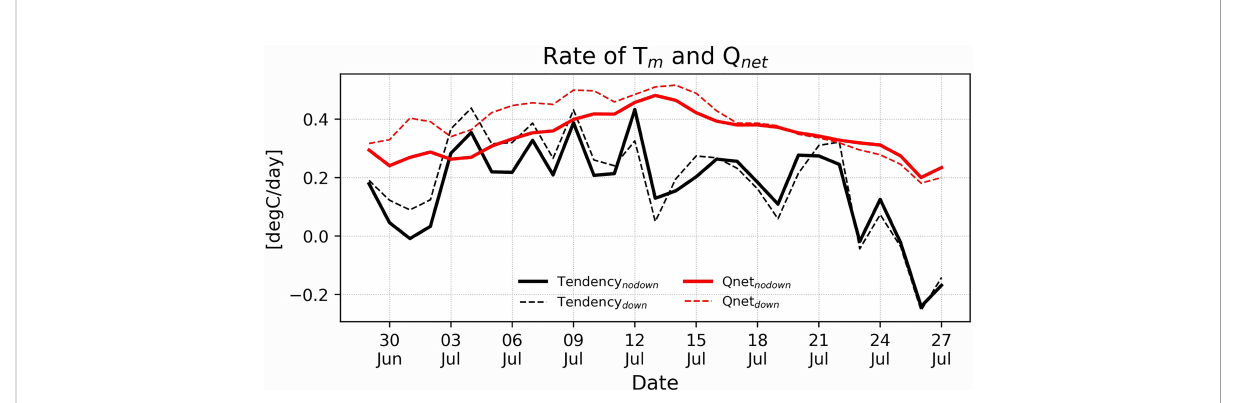
FIGURE 7 Time-series plots of depth-averaged water temperature (T m ) for the mixed layer (tendency; in black) and the net surface heat fl ux Q net (red) for the CPL_nodown (solid) and CPL_down (dashed) simulations over the analysis region (33.5 – 37.5° N, 124.0 – 131.0° E). Q net is the sum of net shortwave radiation, net longwave radiation, sensible heat fl ux, and latent heat fl ux. T m is depth-averaged water temperature up to the mixed